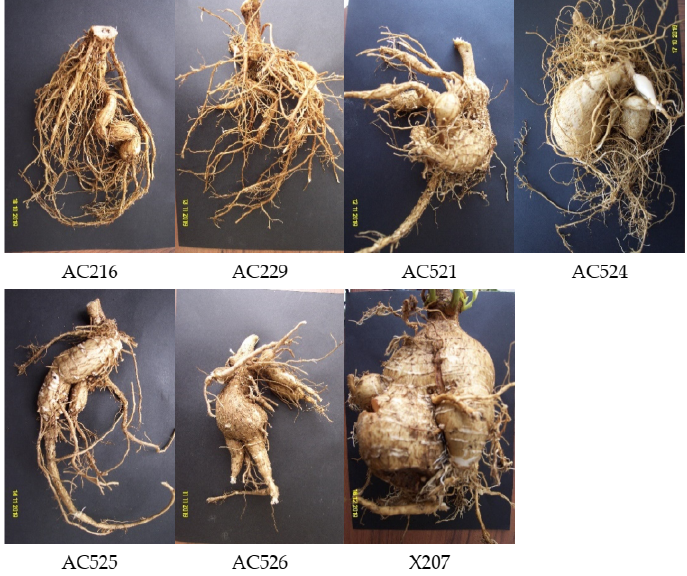
Figure 1. Root morphology in representative samples of the ahipa accessions and the interspecific hybrid